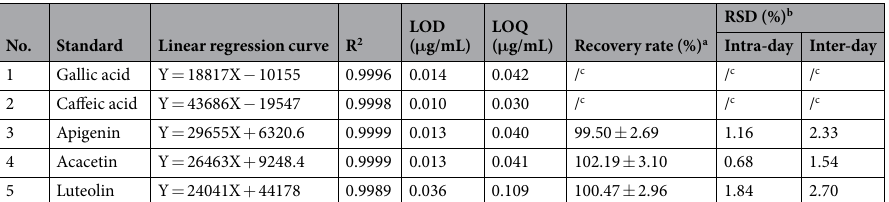
No. Standard Linear regression curve R 2